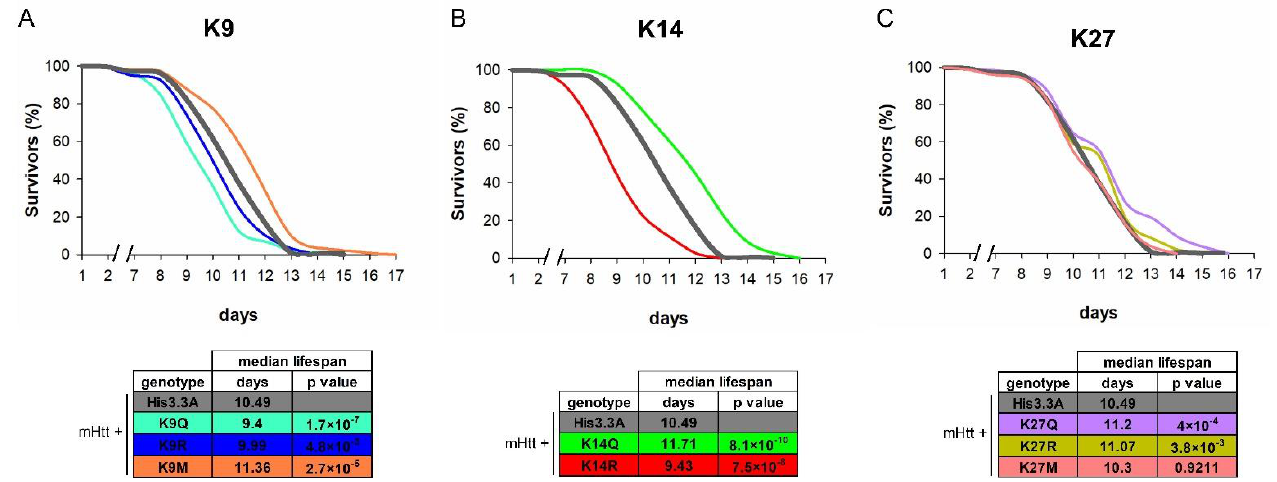
Figure 3. Adult expressions of K9M, K14Q, K27Q, or K27R mutant H3.3-elongated median lifespans of HD flies. Lifespan analysis of male flies co-expressing mHtt + His3.3A-PTM since eclosion in the nervous system under the influence of elav-GAL4 and tubGAL80 ts over a heterozygous His3.3A KO background. ( A ) Expression of His3.3A-K9M increased the median lifespan of HD flies, while the expression of His3.3A-K9Q and His3.3A-K9R shortened it. ( B ) His3.3A-K14Q increased median lifespan, while His3.3A-K14R had the opposite effect. ( C ) Expression of His3.3A-K27Q and His3.3A- K27R transgenes increased median lifespan, while His3.3A-K27M had no effect. Graphs show the percentage of survivors as a function of the number of days after eclosion, n ≥ 200. Fisher’s exact test was used for statistical analysis of median lifespans.